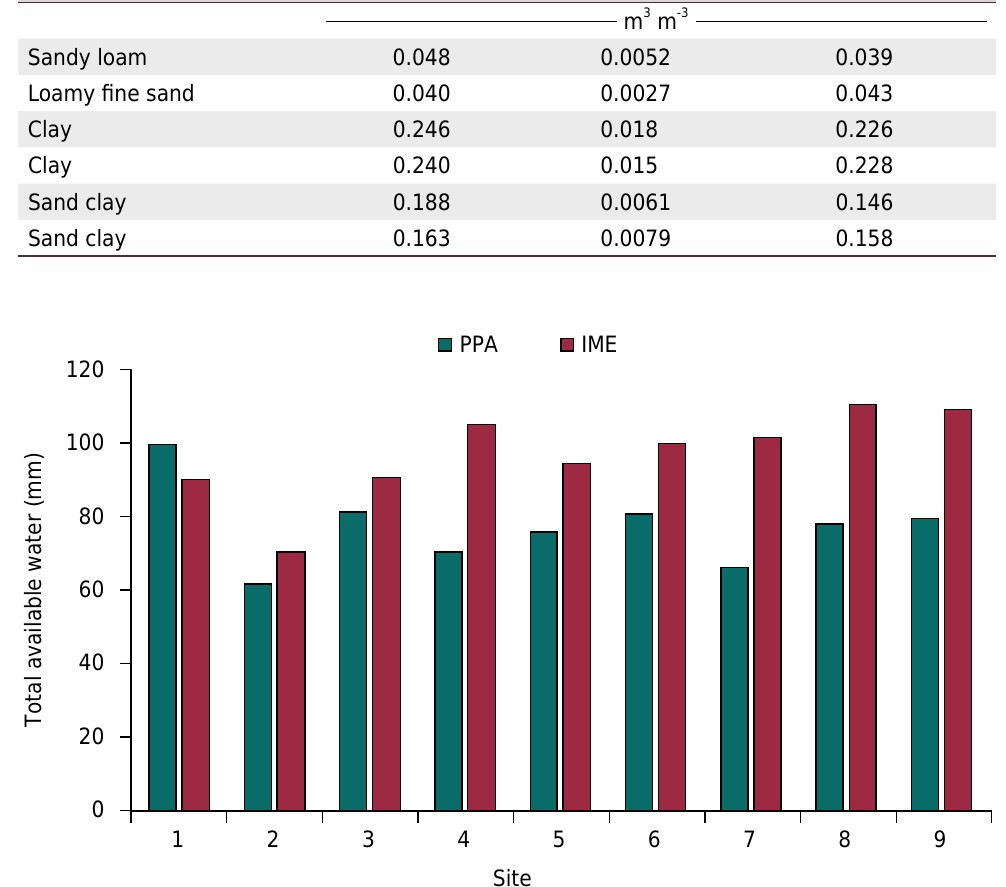
Figure 3. Total available water estimated for nine soils using the θ -h relations obtained by inverse modeling of a laboratory evaporation experiment (IME) and by the tension table/pressure plate apparatus (PPA).